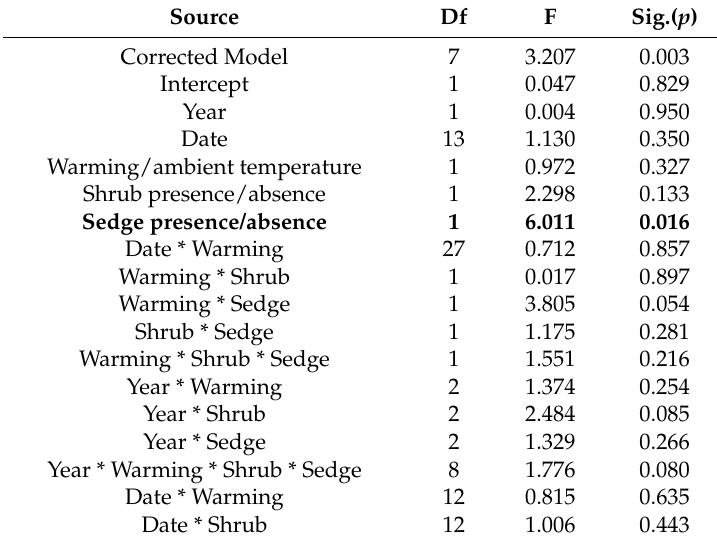
Figure 2. Effects of different treatments on the average N 2 O flux during the growing seasons of 2015–2016. Error bars represent standard errors. Different lowercase letters represent significant differences ( p < 0.05) between the treatments ( n = 60). Table 2. Repeated measures analysis of variance for the effects of warming, vegetation composition, years, and date on N 2 O flux over the growing seasons of 2015 and 2016.